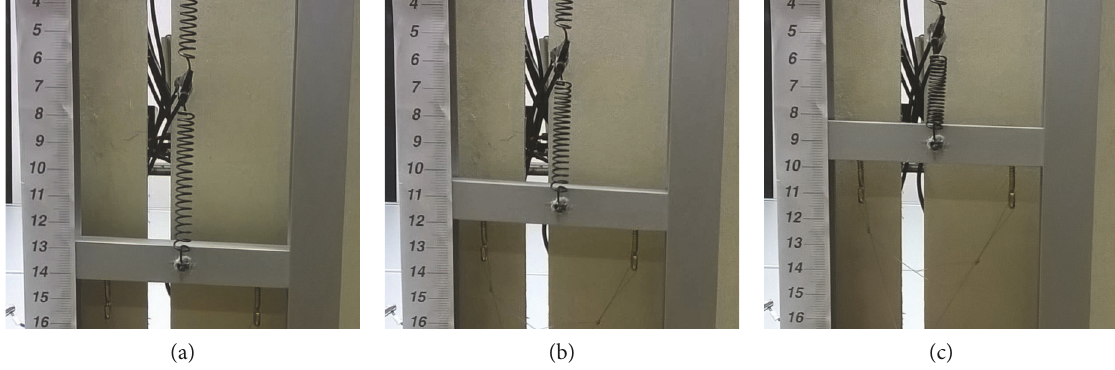
Figure 9: Test I: zero twist proof, both springs stimulated: (a) initial con fi guration; (b) spring contraction; (c) spring at its fi nal minimum length. No angular displacement of the perversion has been observed during the